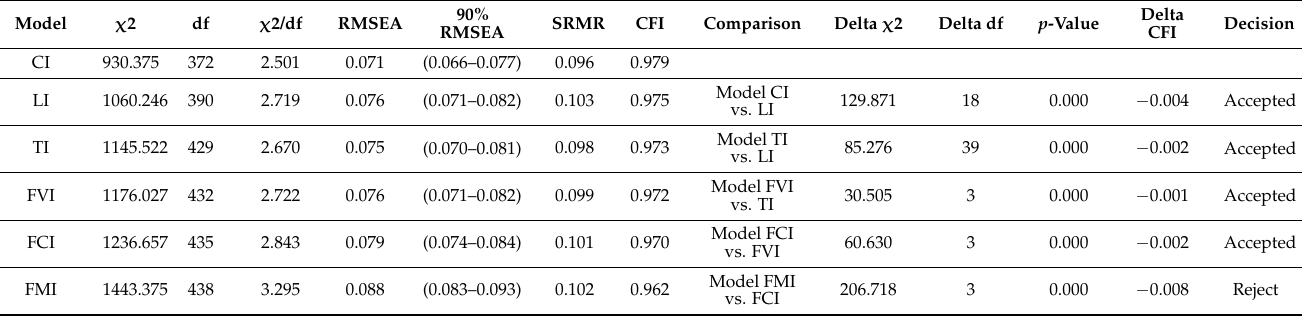
Table 2. DWLS estimation